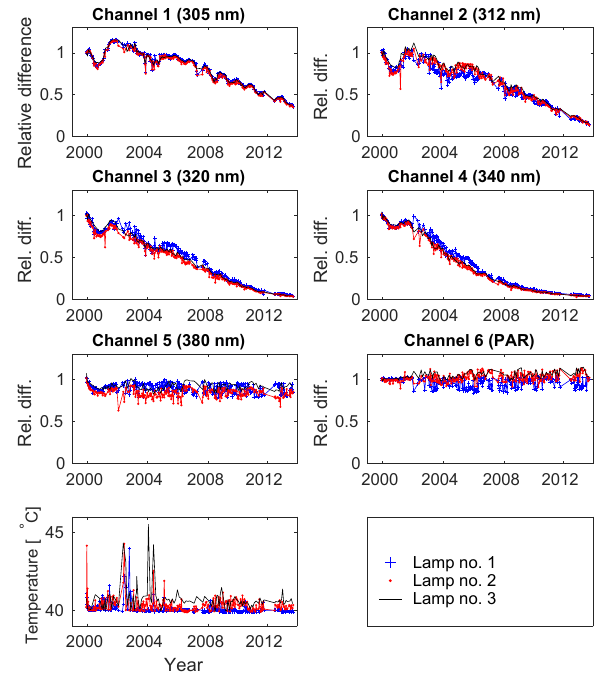
Figure 1. Lamp measurements at Ushuaia during 2000–2013. The raw data of the lamp are divided by the mean of the three first mea- surements. The temperature of the NILU-UV during the measure- ment is also shown.